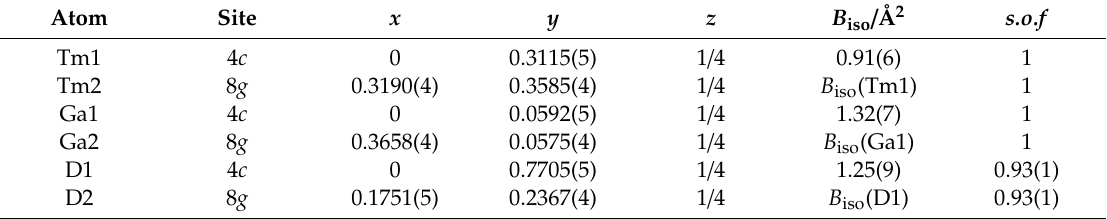
Table 2. Crystal structure of TmGaD 0.93(2) , Cmcm , a = 10.9690(5) Å, b = 12.3722 (6) Å, c = 4.0373 (1)